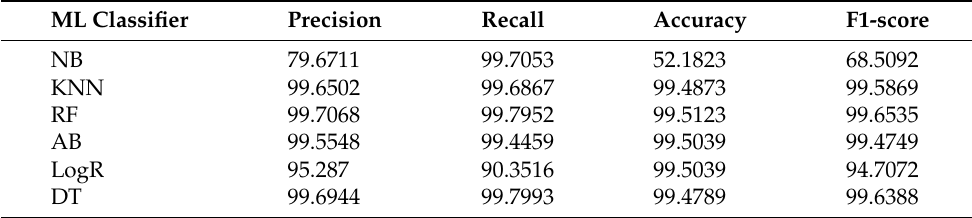
Table 9. Performance evaluation of six commonly used machine learning classifiers test for malicious and normal traffic detection over IoT healthcare dataset generated using IoT-Flock